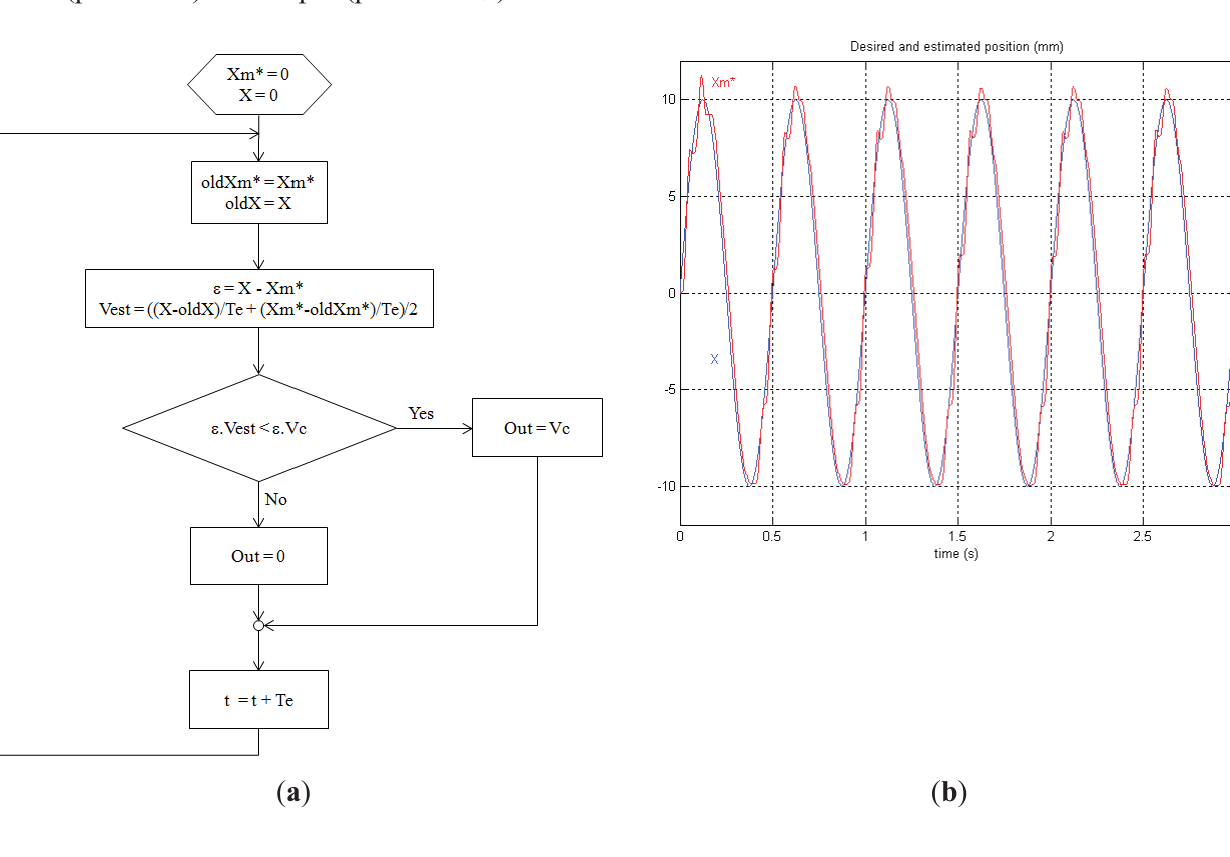
Figure 16. ( a ) Flow chart of the “magic-switch”; ( b ) Closed loop configuration: input * ) (position x ) and output (position x m